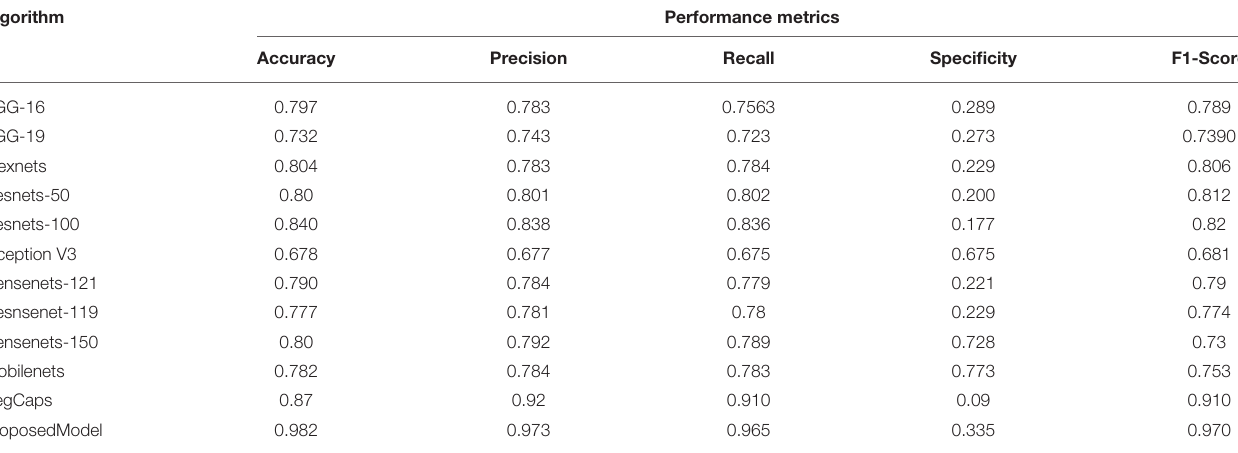
TABLE 3 | Comparative analysis of the different algorithms in detecting the COVID-19 using dataset 2. Algorithm